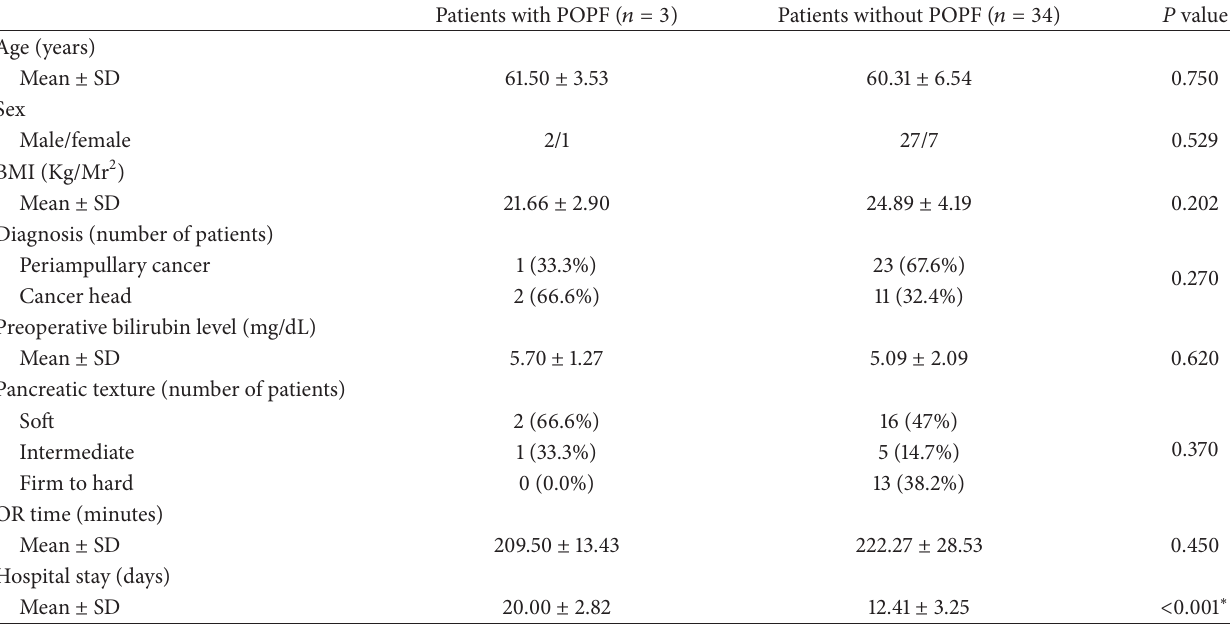
Table 1: Analysis for different risk factors affecting the occurrence of postoperative pancreatic fistula